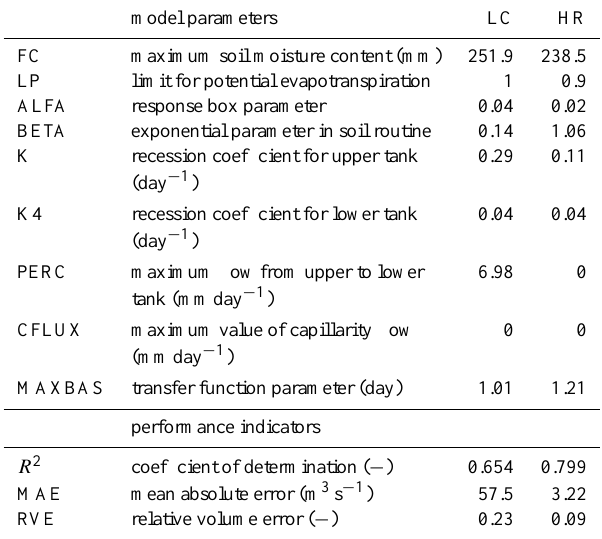
Table 1. Parameterers of the optimally calibrated HBV model for the lake Como (LC) catchment and the hydropower reservoir (HR) catchment, and relevant performance indicators over the validation dataset